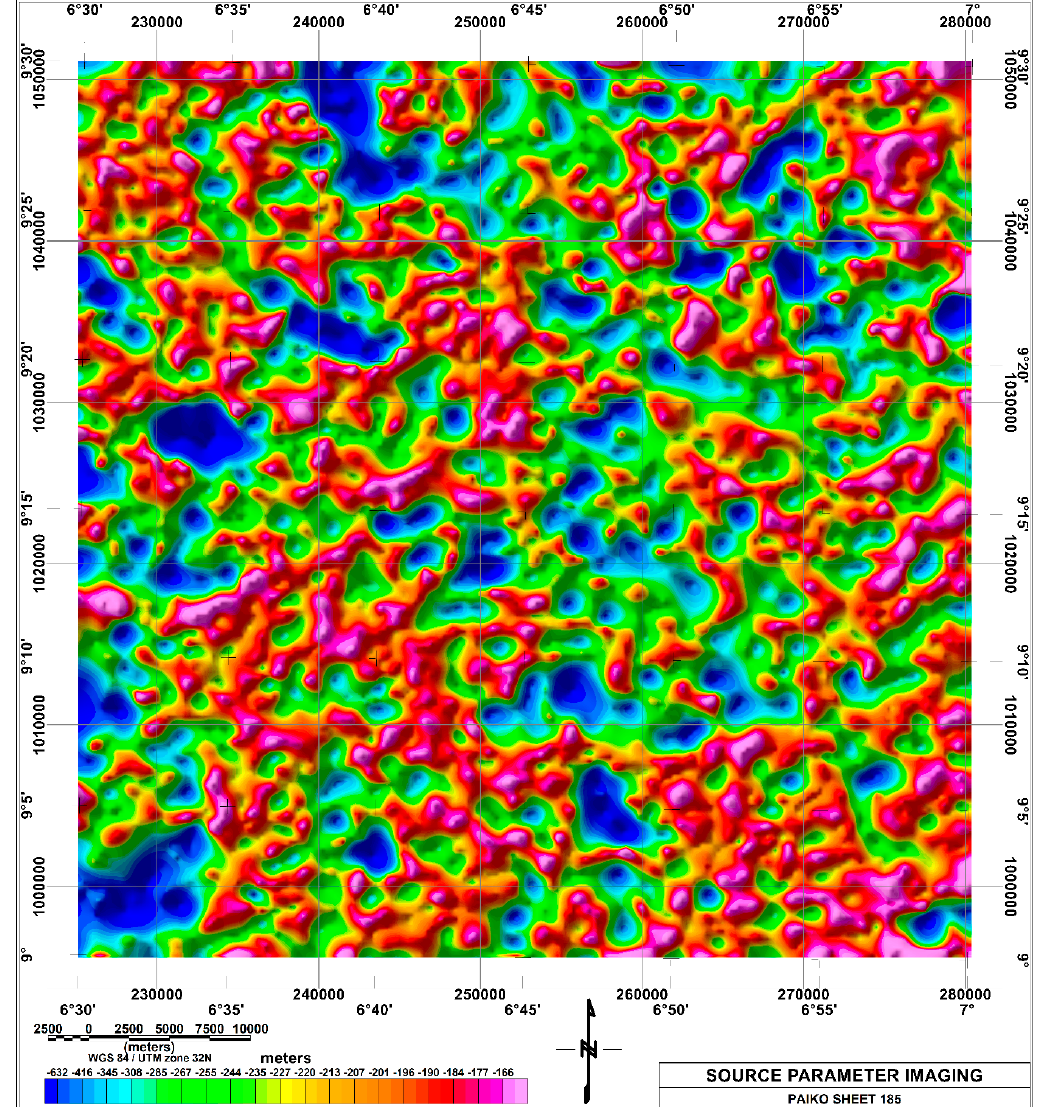
Figure 8. Source Parameter Imaging (SPI) map of Paiko Sheet 185 North Central Nigeria. Areas with blue coloration are representative of deep magnetic features. Shallow areas in magenta in the sedimentary section are attributable to intrusive bodies.